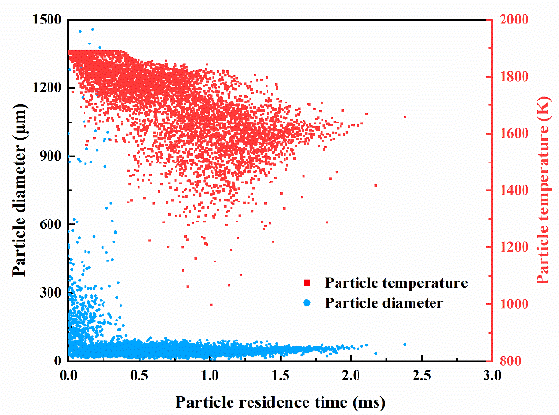
Figure 11. Droplet diameter and temperature distribution history for the KHRT breakup model.